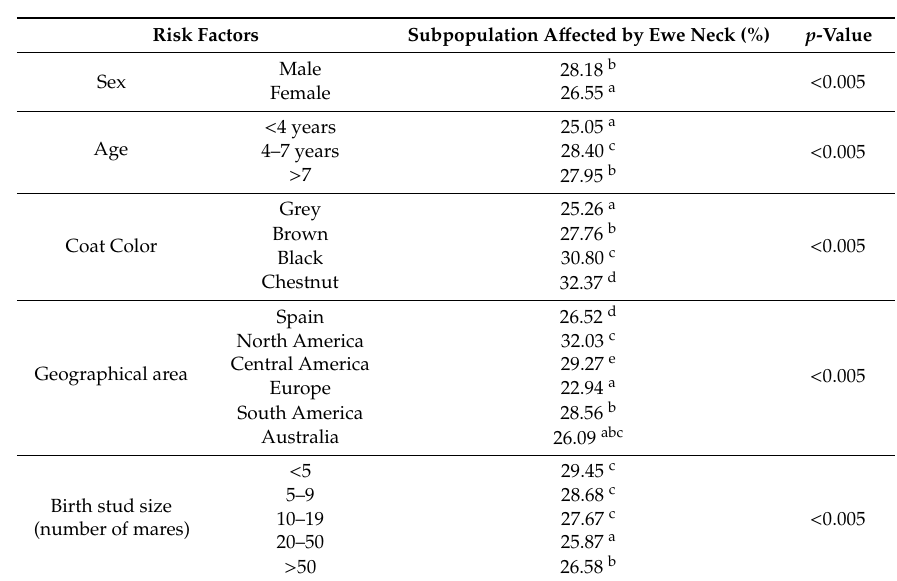
Table 4. Generalized Non-linear Model (GLZ) between the morphological traits with the risk factors and the percentage of subpopulation a ff ected by Ewe Neck (horses with classes 1, 2, and 3), with an association frequency analysis of risk factors (Maximum-Likelihood